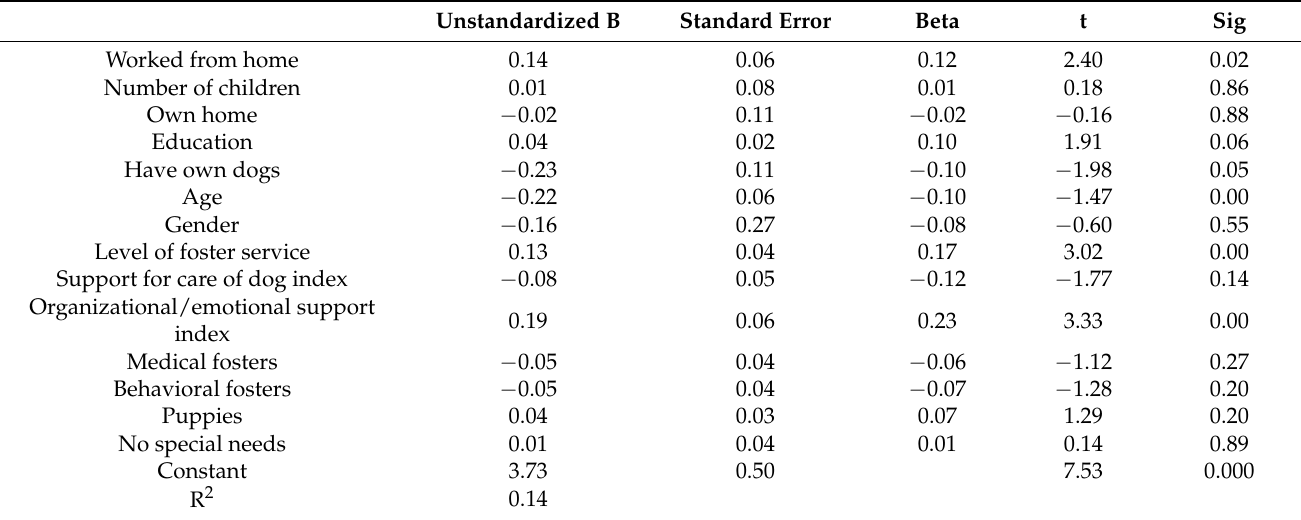
Table 7. Regression: has level of foster service changed during